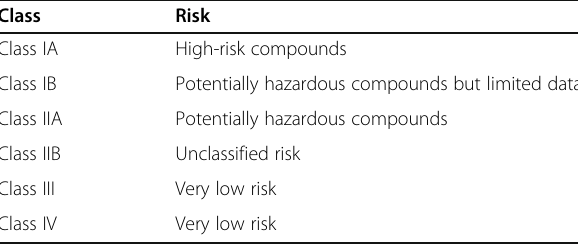
Table 2 Classification of compounds based on potential exposure (PEC a and PEC b values): risk